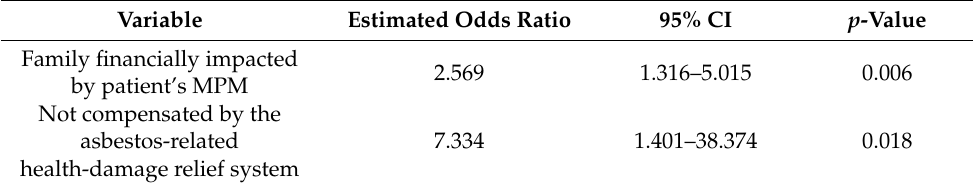
Table 2. Binominal logistic regression model predicting depression ( n = 72).